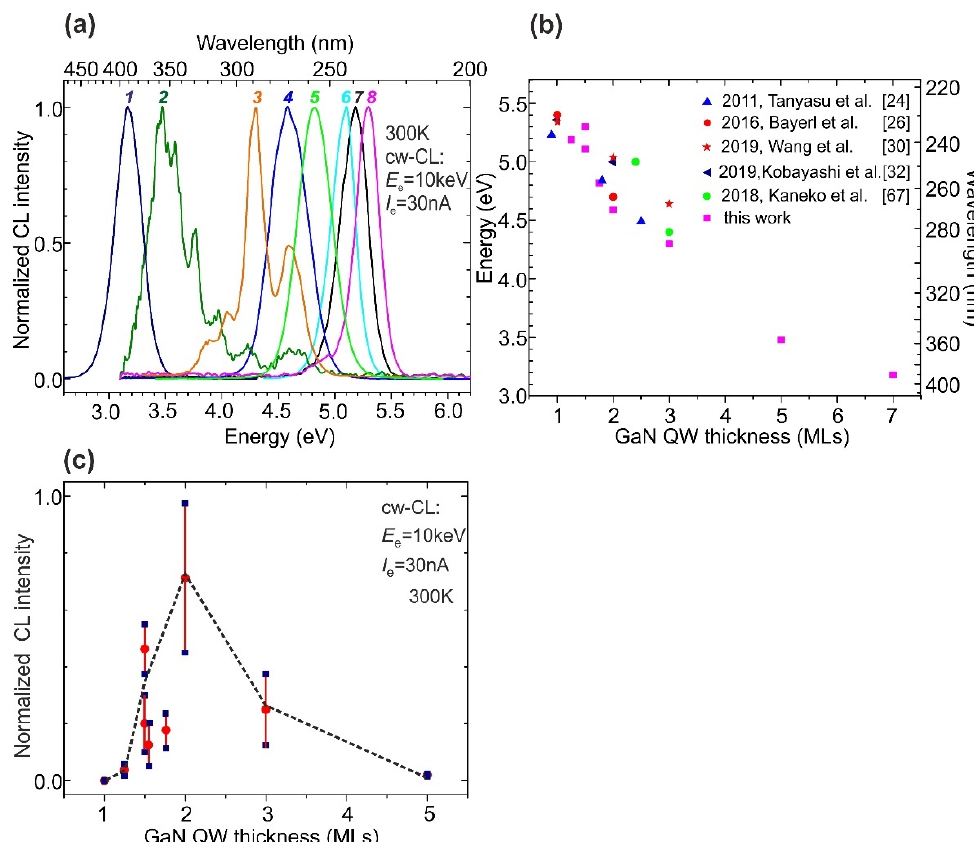
Figure 7. ( a ) Normalized CL spectra at RT of N × {GaN m /AlN n } MQW structures excited with a “low-current” standard thermoionic e-gun at the same I e = 30 nA and E e = 10 keV. The structures were grown with the following parameters: 1 — m = 7 ML, n = 16 ML, N = 25, all samples 2–7 were grown with the same n = 16 ML and N = 100, whereas m varied as 2 — m = 5 ML, 3 — m = 3 ML, 4 — m = 2 ML, 5 — m = 1.75 ML, 6 — m = 1.5 ML, 7 — m = 1.25 ML, in 8 — m = 1.5 ML, n = 22 ML, and N = 120 [29]. ( b ) Energies of PL and CL peaks measured for ML-scale GaN/AlN MQW structures grown using both PA MBE and MOVPE. ( c ) The dependence of the CL peak intensity on the nominal well thickness ( m ) in the MQW structures with CL spectra shown in ( a ).